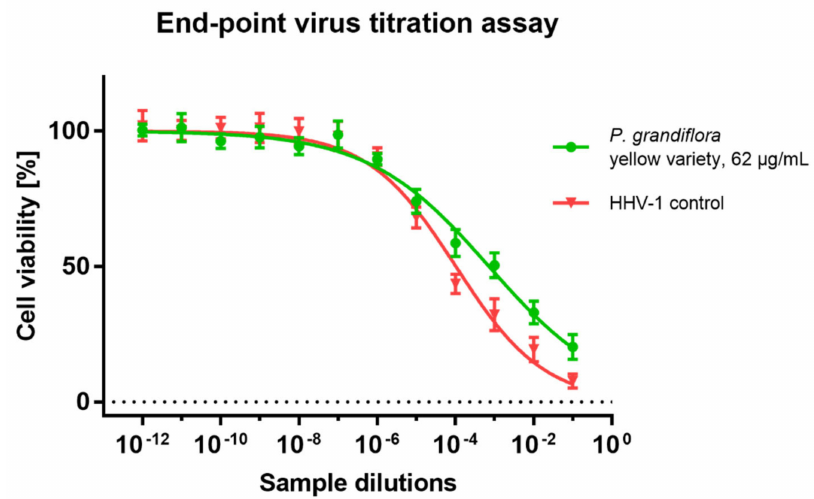
Figure 6. The end-point dilution assay of HHV-1 infectious titer in P. grandiflora yellow-variety extract-treated infected cells.